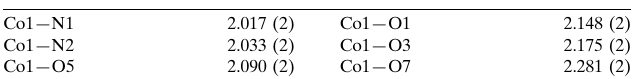
Selected bond lengths (A˚ ).